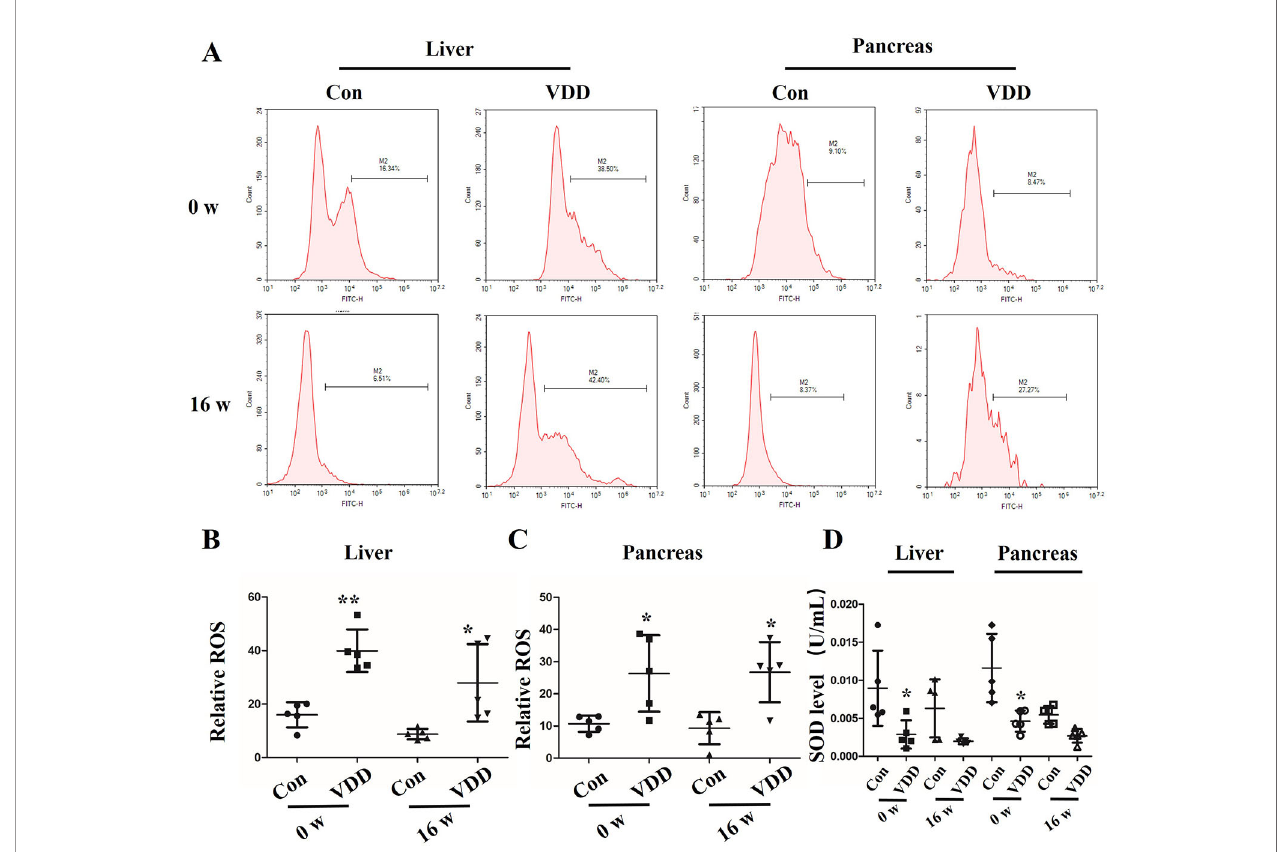
FIGURE 3 | Maternal 25-hydroxyvitamin D de fi ciency decreases the antioxidation ability in offspring liver and pancreas tissues. (A) The liver and pancreas ROS levels in offspring at week 0 or 16 was assessed by fl ow cytometry using the CM-H2DCFDA fl uorescence probe. (B, C) The percentage of fl uorescence intensity was calculated as relative ROS level in liver (B) and pancreas (C) at week 0 and 16. (D) SOD levels were detected in the offspring liver and pancreas at week 0 and 16. Mean ± SD, n = 5 rats per group. * P < 0.05, ** P < 0.01, vs. control group. Normal group, Con; maternal 25-hydroxyvitamin D de fi ciency group, VDD; week,